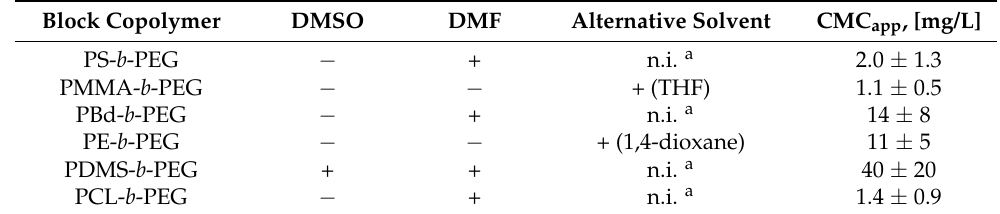
Table 3. Stability of dispersions prepared by solvent exchange method using different solvents and CMC app values for micelle